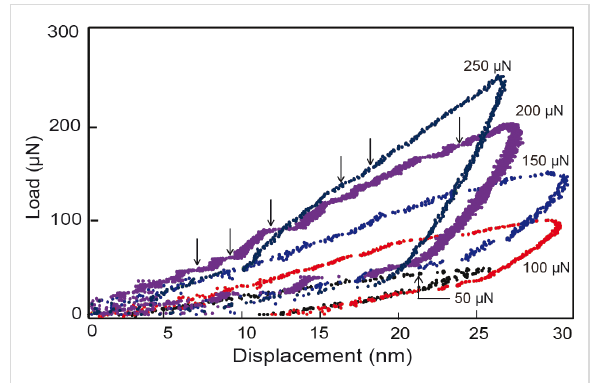
Figure 12: Examples of repeat load–displacement curves for Au 500 nanoparticles with the corresponding maximum loads for each compression event. Vertical arrows point to pop-in events. Increments of 50 µN were applied in a range of 50–250 µN. Evidence of strain hardening can be seen where successive loads after 150 µN result in the displacement being the same or less after